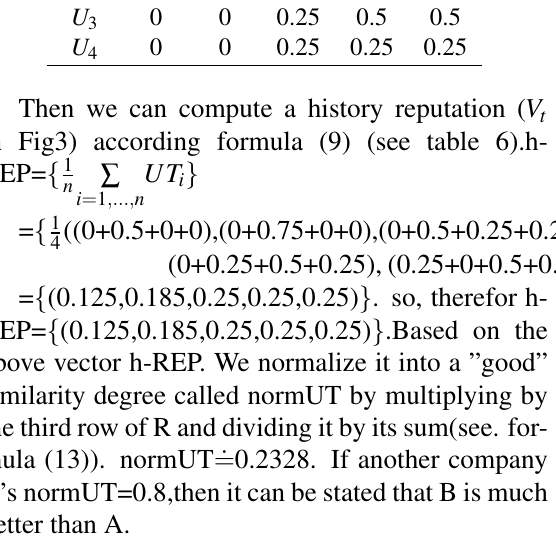
Table 5. User Trust Degree to X